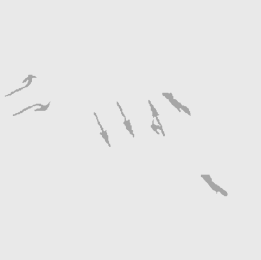
Figure 7. Sample resulting segmented image mask.